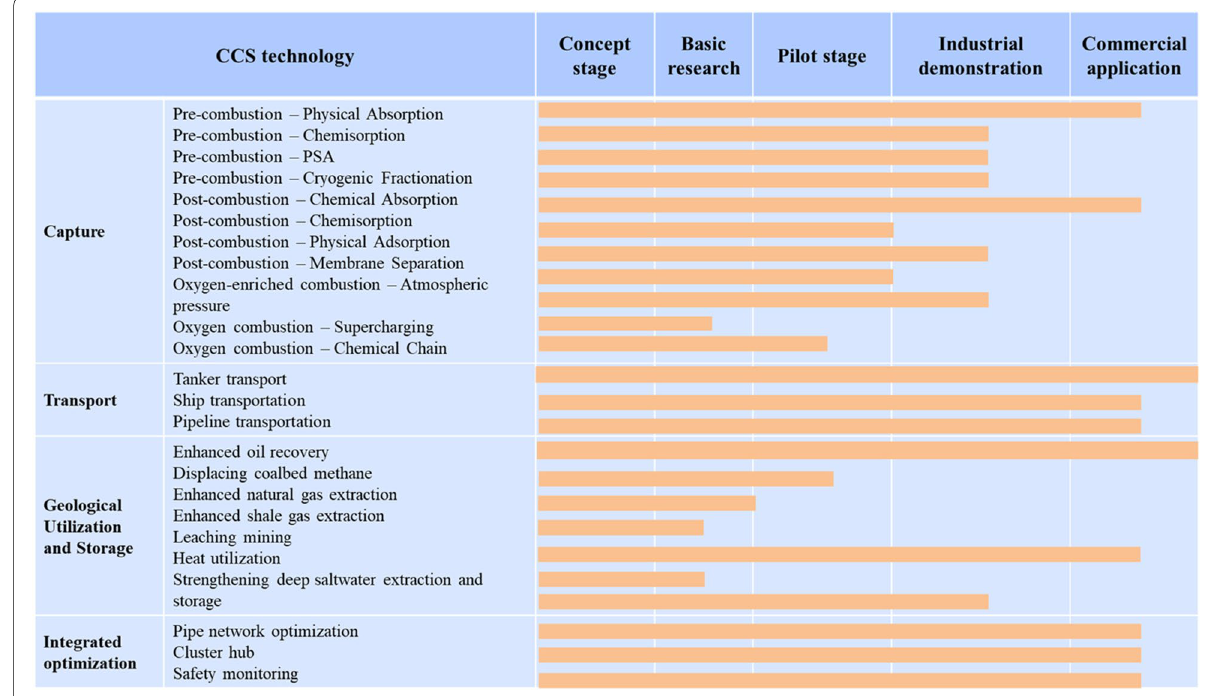
Fig. 1 CCS technology development level in